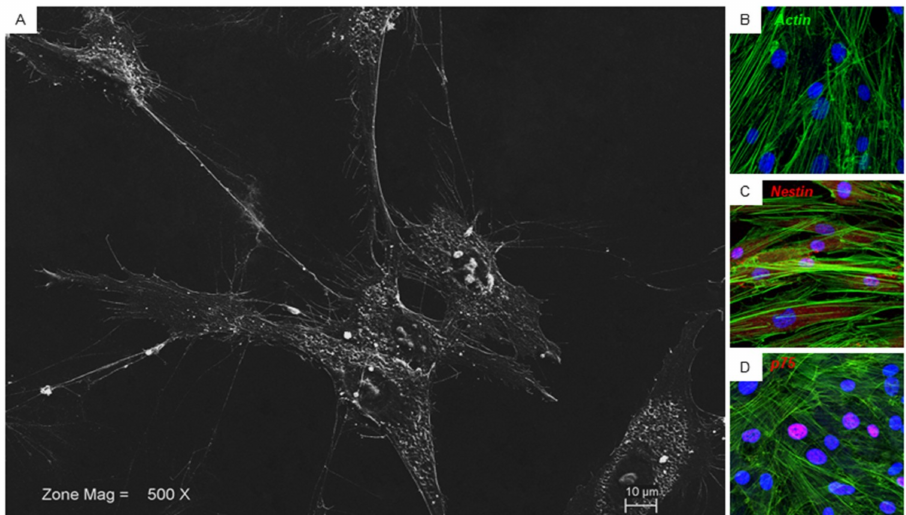
Figure 2. hPDLSCs morphological features. ( A ) Glass adherent hPDLSCs observed at SEM. ( B ) hPDLSCs observed at CLSM, green fluorescent stained the cytoskeleton actin. ( C ) hPDLSCs showed a positivity for nestin (red fluorescent). ( D ) hPDLSCs showed a positivity for p75 (red fluorescent). Nuclei were stained with TOPRO (blue fluorescent). Bar: 10 µ